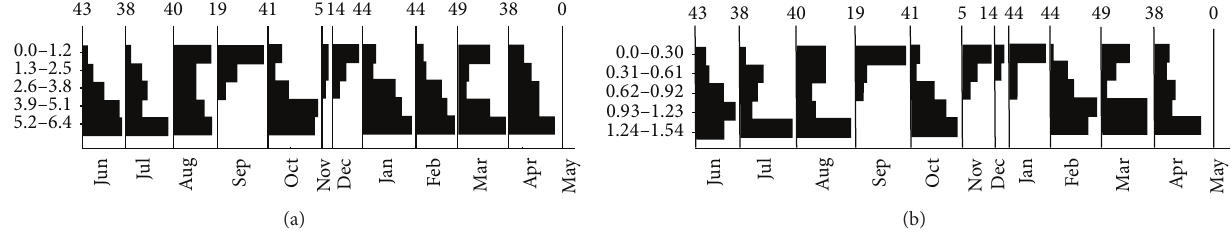
Figure 4: Size frequency distribution of (a) body length (mm) and (b) head width (mm) of C. alagarensis .